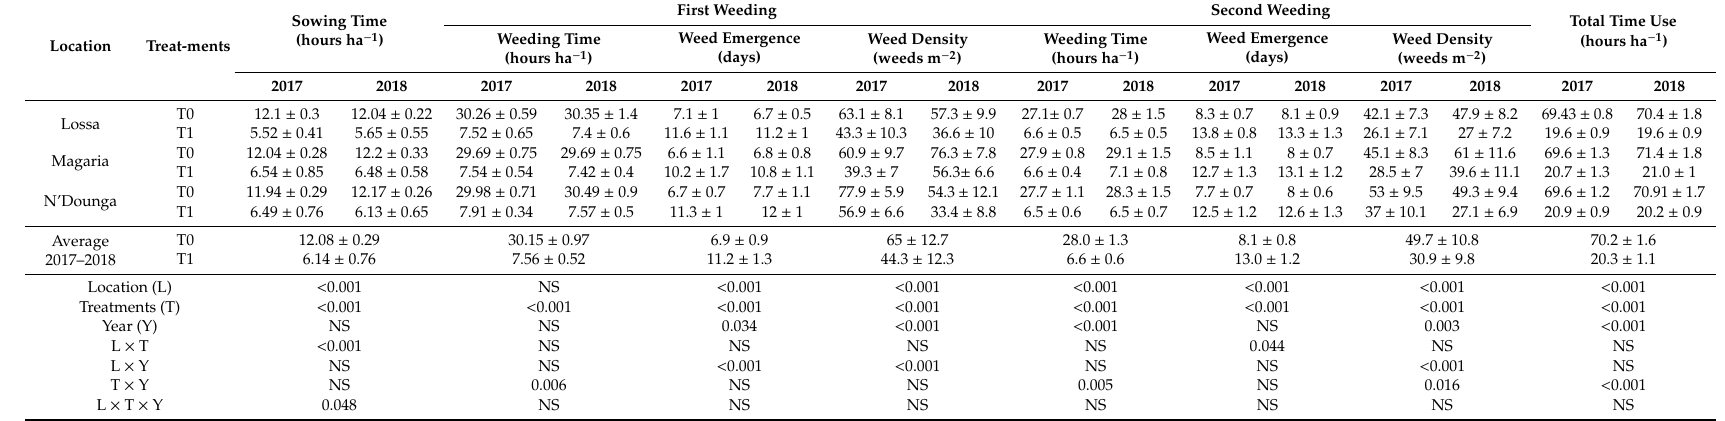
Table 1. The e ff ect of treatments on labour use (sowing and weeding), days to weed emergence, and weed density. Probability of main e ff ects and interactions included.